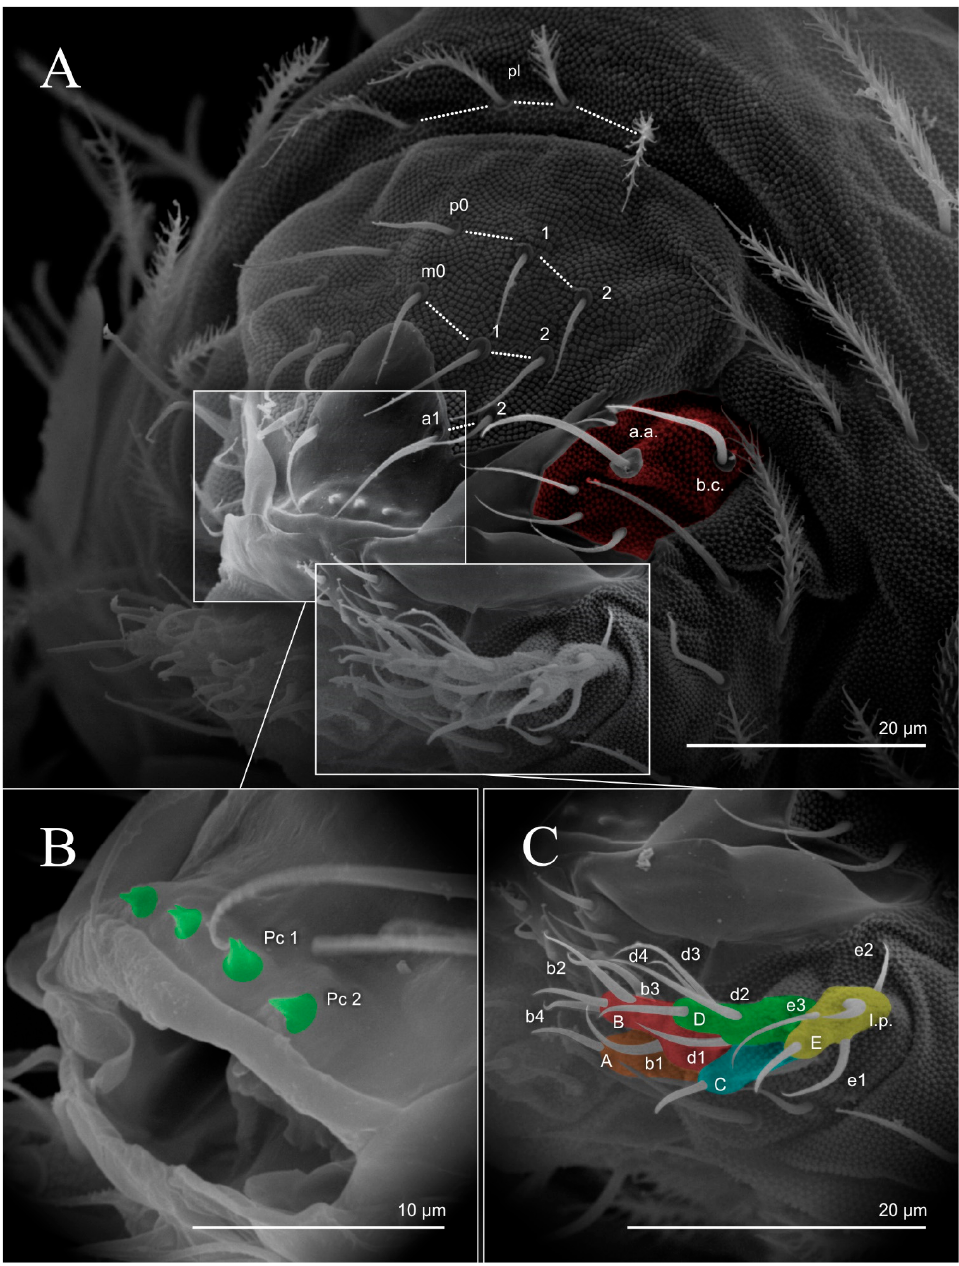
Figure 8. Seira musarum SEM: mouth parts. ( A ), prelabral, labral chaetotaxy; maxillary palp and sublobal plate; ( B ), papillary crests; ( C ), labial palps.